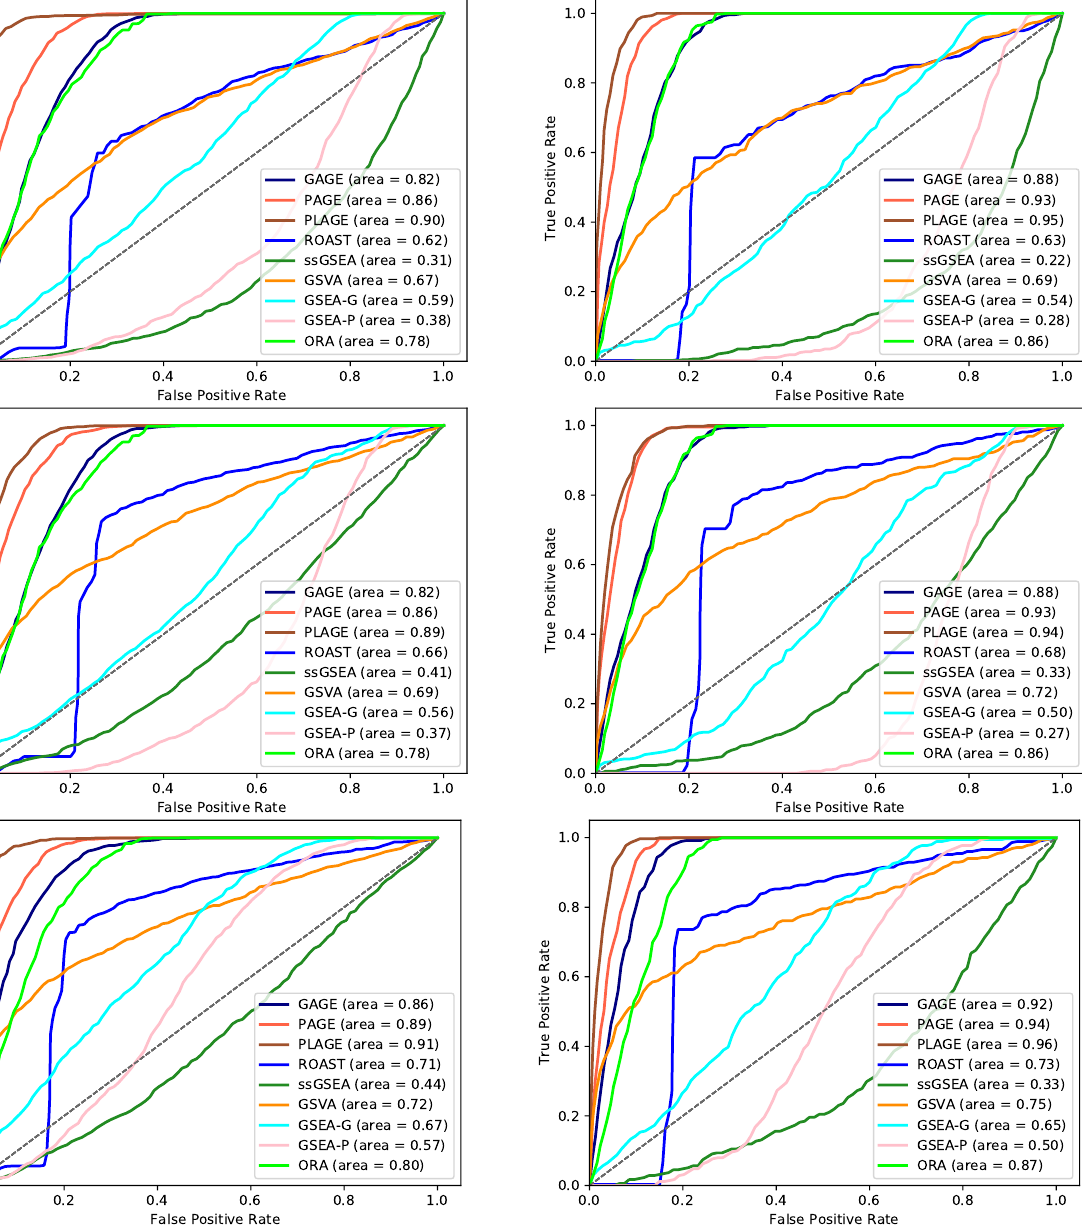
Figure 7. Receiver operator characteristic curves (ROC) for each method using γ = 0.3 ( left column ) and 0.5 ( right column ) for the datasets synthesized based on microarray datasets, GSE53757 and GSE13355; and RNA-Seq dataset GSE54456 (from top to bottom). The plots show the relationship between the true positive rate (y-axis) and the false positive rate (x-axis). A method with higher area under the curve (shown for each method) is considered better. The black dotted diagonal line (y = x) represents a method with random ordering of significance values. Note that SetRank is not included in the ROC curves as the order of the non-significant differentially enriched gene sets is not reported by this